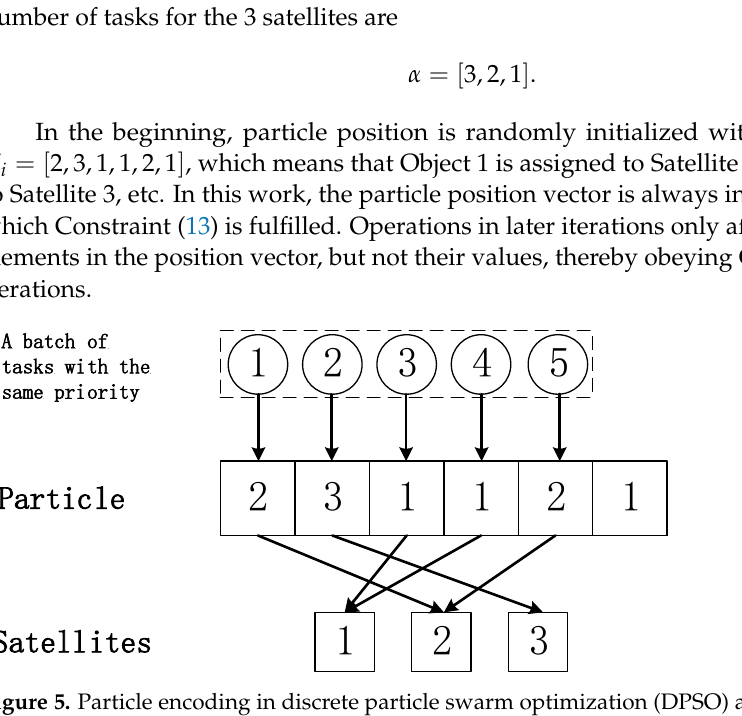
Figure 5. Particle encoding in discrete particle swarm optimization (DPSO) algorithm for multiple- satellite and -object task-planning